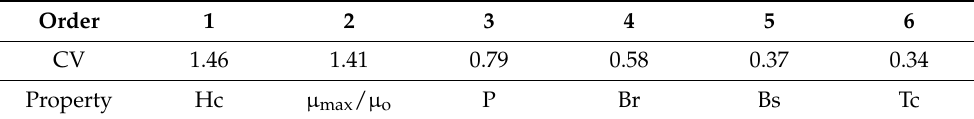
Table 3. Priority of physical characteristics for ranking the soft magnetic